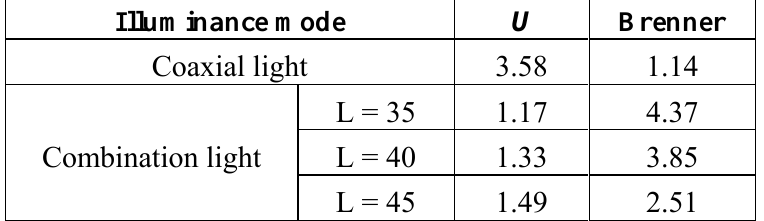
Table 2. Uniformity and articulation of image in different illuminance